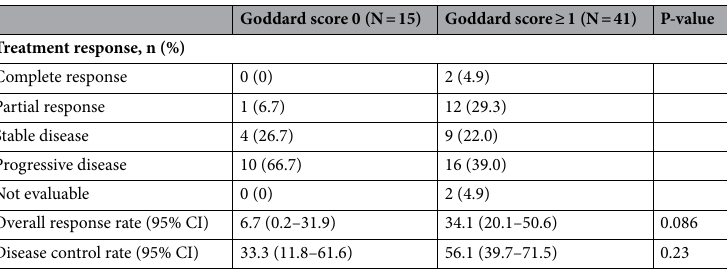
Table 2. Treatment outcome according to the Goddard score. CI confidence